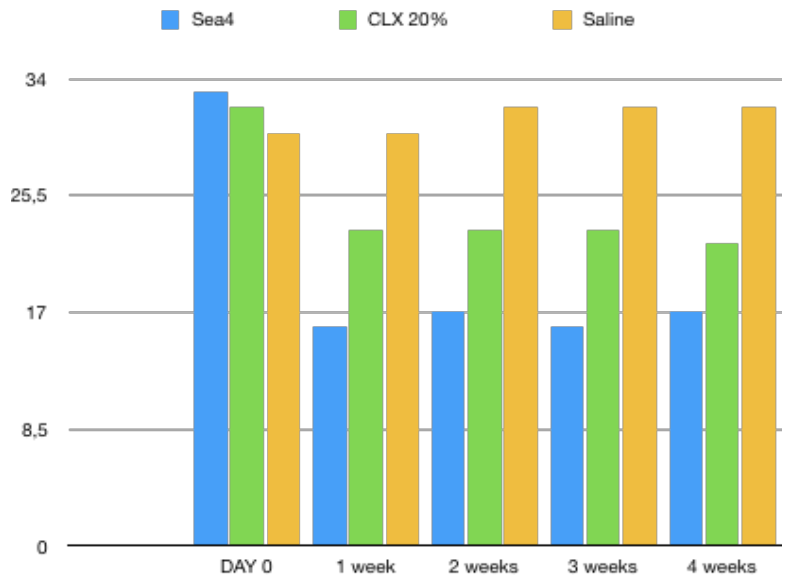
Figure 3. Plaque index frequency. Sea4 Encias produced a more significant reduction in plaque at four weeks than the other two mouth rinses.